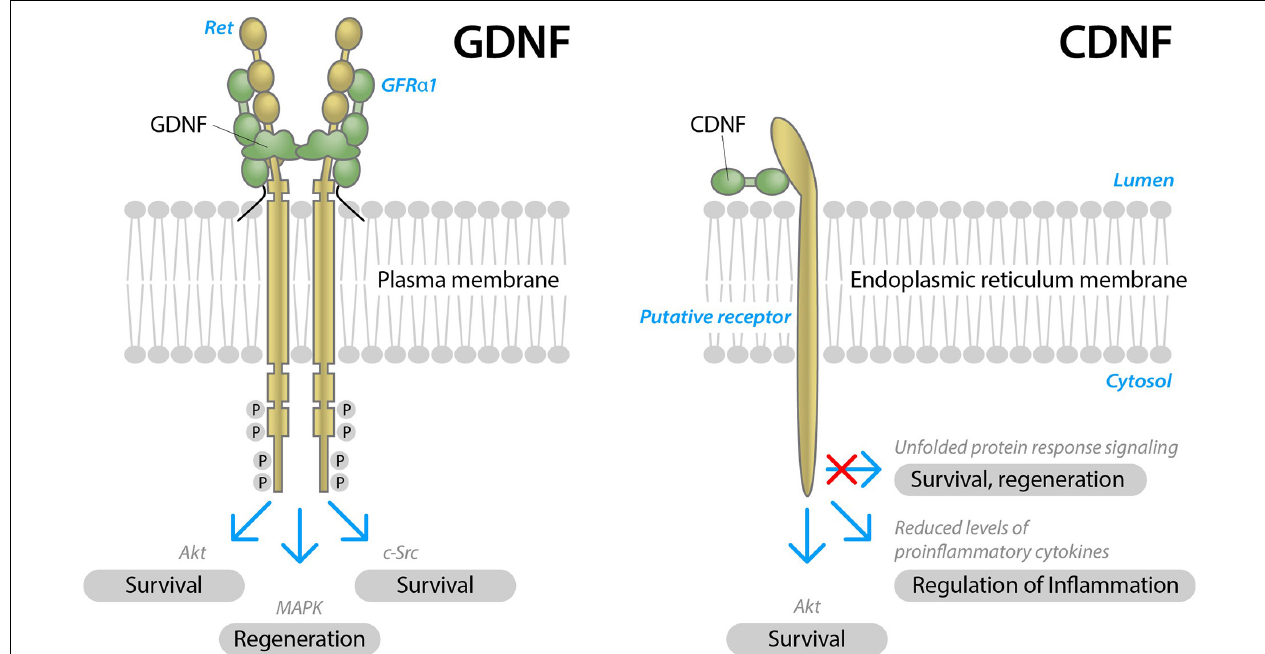
FIGURE 2 | Schematic structure of two neurotrophic factors, GDNF and CDNF, and their modes of action in neurons. GDNF signals through receptor tyrosine kinase RET in the presence of a GDNF binding co-receptor, GFR α 1. Upon activation, RET is transphosphorylated at cytoplasmic tyrosine residues and triggers complex intracellular signaling cascades, Akt, MAPK, and c-Src signaling pathways, promoting the survival and regeneration of neurons (modified from Airaksinen and Saarma, 2002). CDNF receptors are not identifyed yet. Presumably, CDNF signals through the receptor localized on the endoplasmatic reticulum membrane, alleviating unfolded protein response, reducing inflammation and promoting the survival of